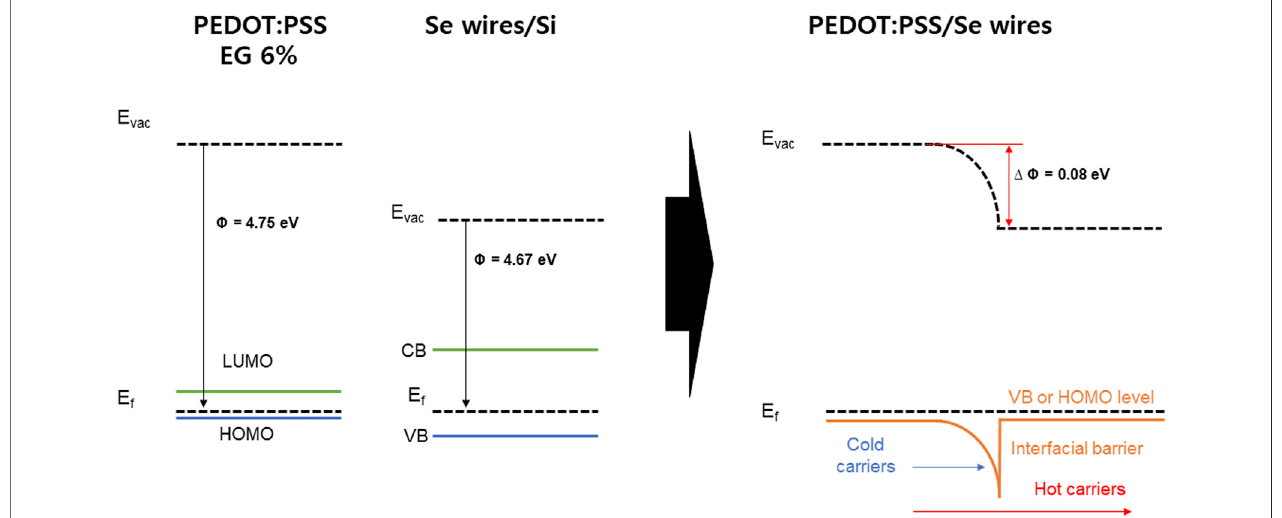
FIGURE 9 | Energy diagram of the PEDOT:PSS and Se wires/Si and energy fi ltering effects at PEDOT:PSS/Se wires junctions.